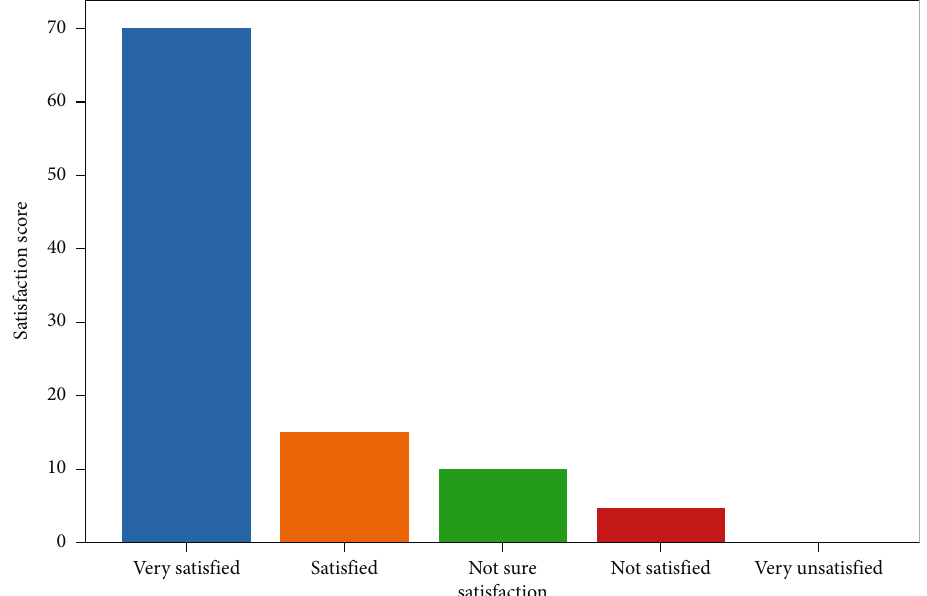
Figure 8: Evaluation of classroom e ff ects of integrating speech synthesis technology into drama education for preschool